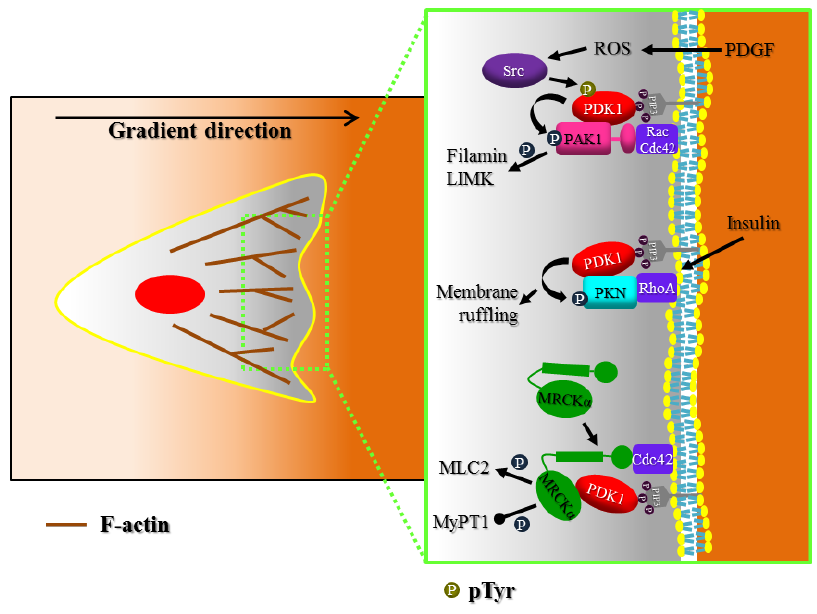
Figure 3. PDK1 regulates membrane protrusions and actin polymerization. After being polarized, migrating cells have to extend active membrane protrusions, including lamellipodia and filopodia at the cell front. Extension of both lamellipodia and filopodia in response to chemoattractant is almost universally found coupled with local actin polymerization. PDK1 controls this process through the phosphorylation of p21-activated kinase 1 (PAK1) and protein kinase N (PKN), downstream to both PI3K and Rho GTPases. On the contrary, PDK1 regulates activity of MRCKα through a kinase-independent mechanism.